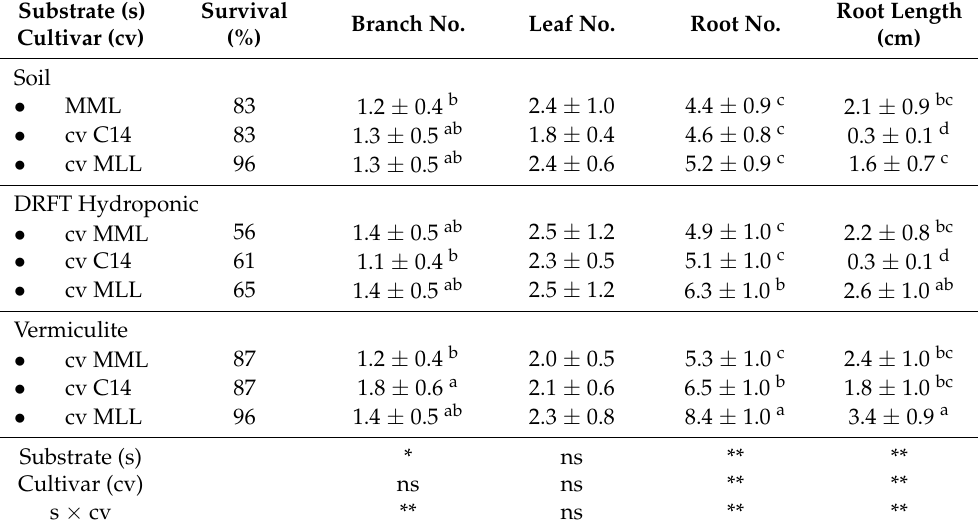
Table 1. Survival percentage, fresh weight, branch, leaf and root number, and root length of mulberry single–node cuttings from three cultivars: Myanmar medium leaf (MML), C14, and Myanmar large leaf (MLL), 30 days after insertion of single–node segments to three different systems of soil, DRFT hydroponic, or vermiculite–based substrates supplemented with Hoagland